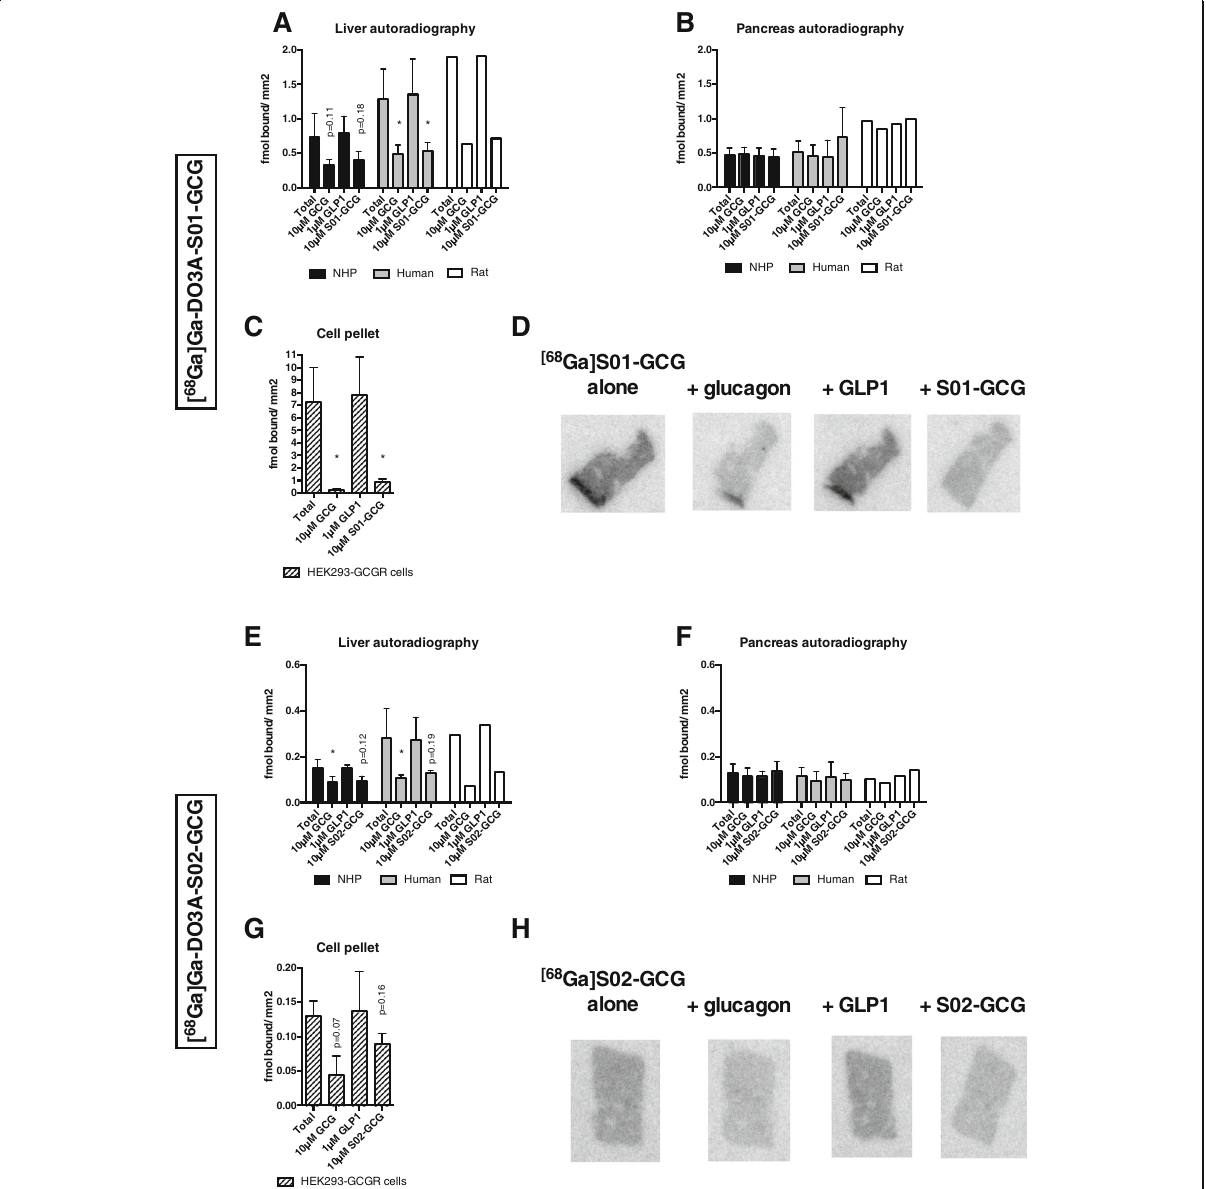
Fig. 3 In vitro autoradiography of [ 68 Ga]Ga-DO3A-S01-GCG or [ 68 Ga]Ga-DO3A-S02-GCG. Binding of [ 68 Ga]Ga-DO3A-S01-GCG to sections of the liver ( a ) and pancreas ( b ) from NHP ( n = 3), human ( n = 3), or rat ( n = 1), or HEK293 cells overexpressing GCGR ( n = 3) ( c ). Representative autoradiograms of [ 68 Ga]Ga-DO3A-S01-GCG binding in the human liver ( d ). Binding of [ 68 Ga]Ga-DO3A-S02-GCG to sections of the liver ( e ) and pancreas ( f ) from NHP ( n = 3), human ( n = 3), or rat ( n = 1), or HEK293 cells overexpressing GCGR ( n = 3) ( g ). Representative autoradiograms of [ 68 Ga]Ga-DO3A-S02-GCG binding in the human liver ( h ). The sections were incubated either with radiotracer alone (Total) or together with 10 μ M GCG, 1 μ M GLP-1, or 10 μ M of respective tracer precursor peptide S01-GCG or S02-GCG. Stars or p values above bars indicate difference